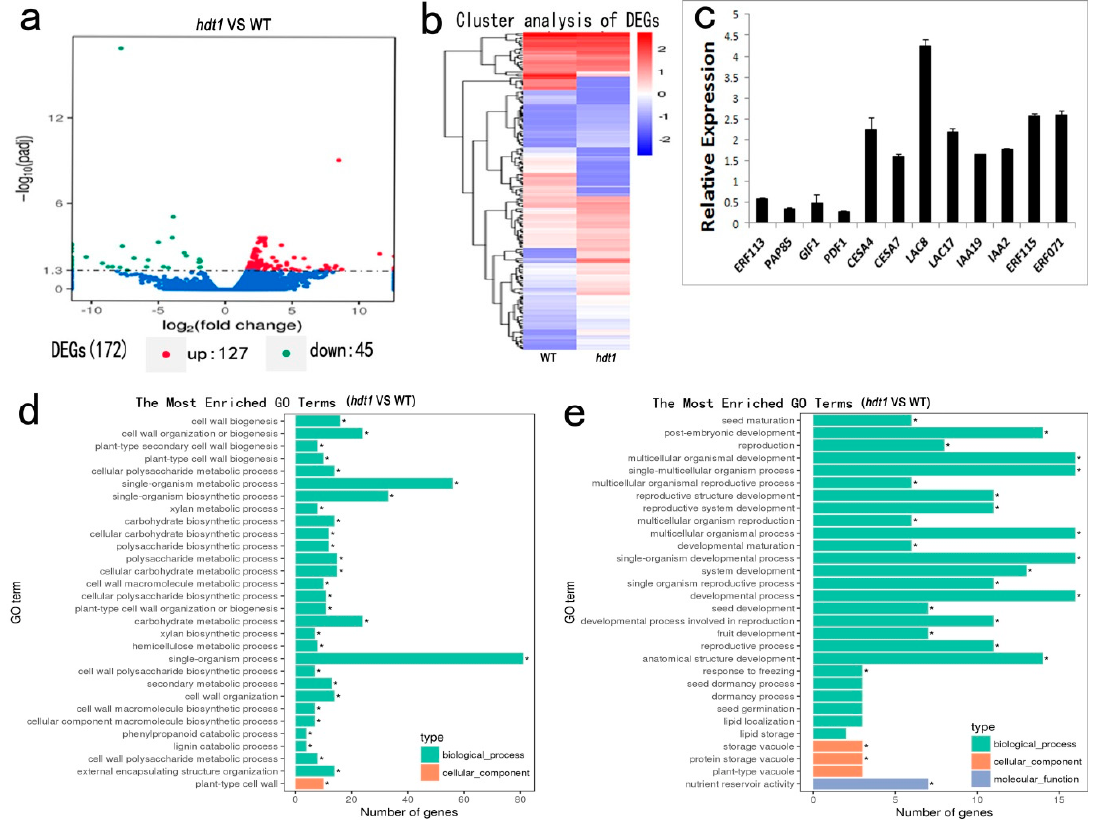
Figure 4. Transcriptomic analysis of di ff erentially expressed genes. ( a ) Genes with significant di ff erences in expression are indicated in the volcano plot by red dots (upregulation), green dots (downregulation), and blue dots (no significant di ff erence). ( b ) Hierarchical cluster analysis of di ff erentially expressed genes ( hdt1 versus the wild type). Red color indicates high expressed genes and blue color indicates low expressed genes in each sample. ( c ) Real-time quantitative analysis of di ff erentially expressed genes (hdt1 mutant vs. the wild type). ( d , e ) GO enrichment analysis of the significantly upregulated ( d ) and downregulated ( e ) genes ( hdt1 mutant vs. the wild type; *, p < 0.005, log 2 fold change > 1 or < − 1) in the T3 stage. GO terms were sorted based on the p -value. Table 1. Expression patterns of selected vascular tissue related genes.